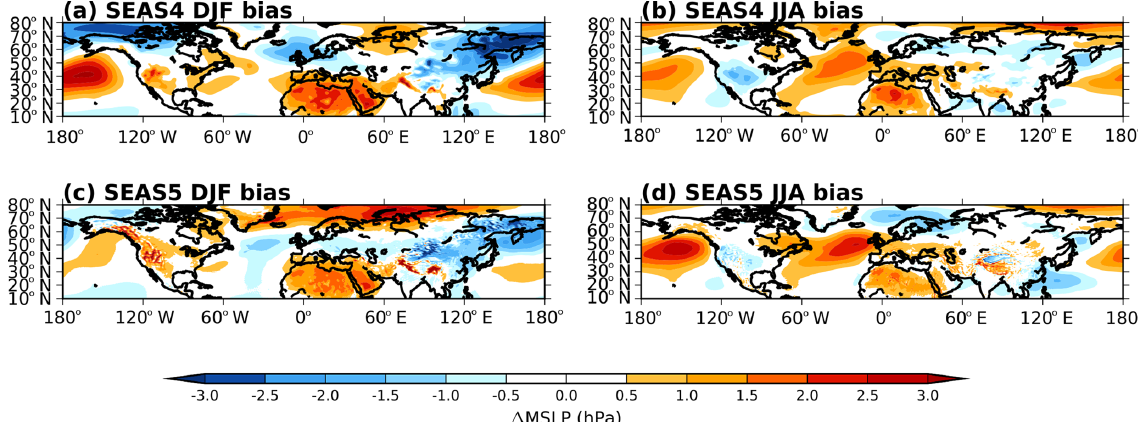
Figure 10. Northern extratropics DJF and JJA mean sea level pressure (MSLP) bias with respect to ERA-Interim in SEAS4 (a, b) and SEAS5 (c, d) at 1 month forecast